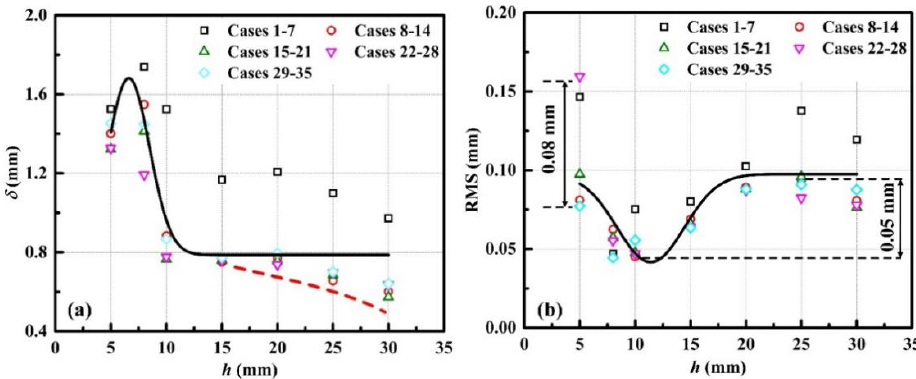
Figure 12. Variations of the liquid film thickness at stagnation points. ( a ) variations of the time- average film thickness, ( b ) variations of the RMS in Cases 1–35.